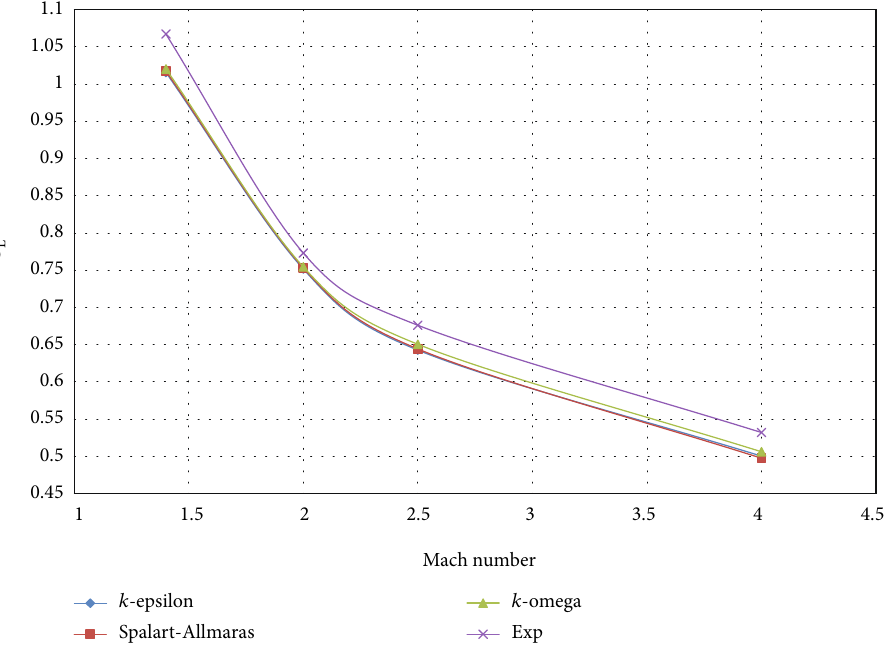
Figure 7: Lift coe ffi cient versus Mach number at 4 ° ( R N ), nose front radius ( R F ), tail fi n position ( X F ), fi n span ( L FS ), leading-edge ( γ le ) and trailing-edge ( γ te ) sweepbacks, root chords ( L FR ) and tip chords ( L FT ) of the tail fi n, and root ( T r ) and tip ( T t ) thickness of the tail fi n were chosen to fi nd the opti- sents the design variables for the missile body, nose, and tail fi n.